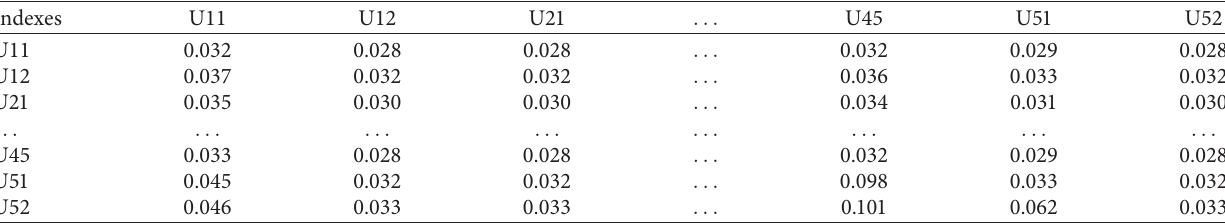
Table 3: Comprehensive relation matrix.